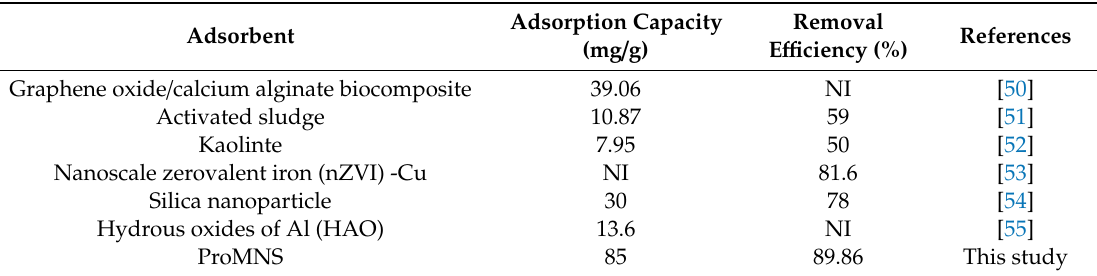
Table 3. Adsorption capacity and removal efficiency of protein-modified nanosilica (ProMNS) and other absorbents for ciprofloxacin (CFX) removal.